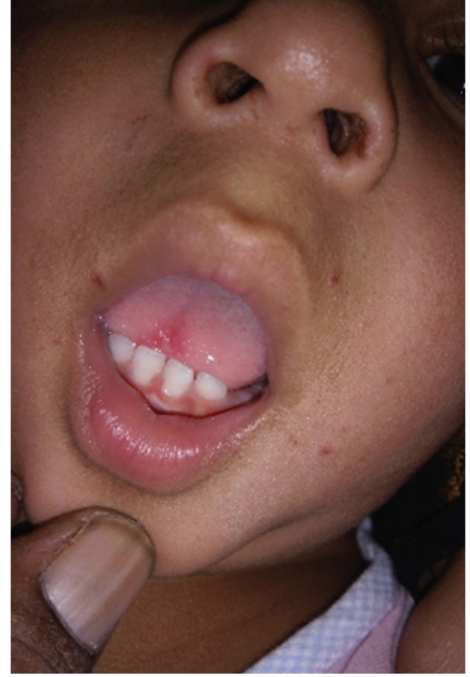
Figure 2. An oral ulcer on tongue with surrounding erythema of a 5-year old boy.